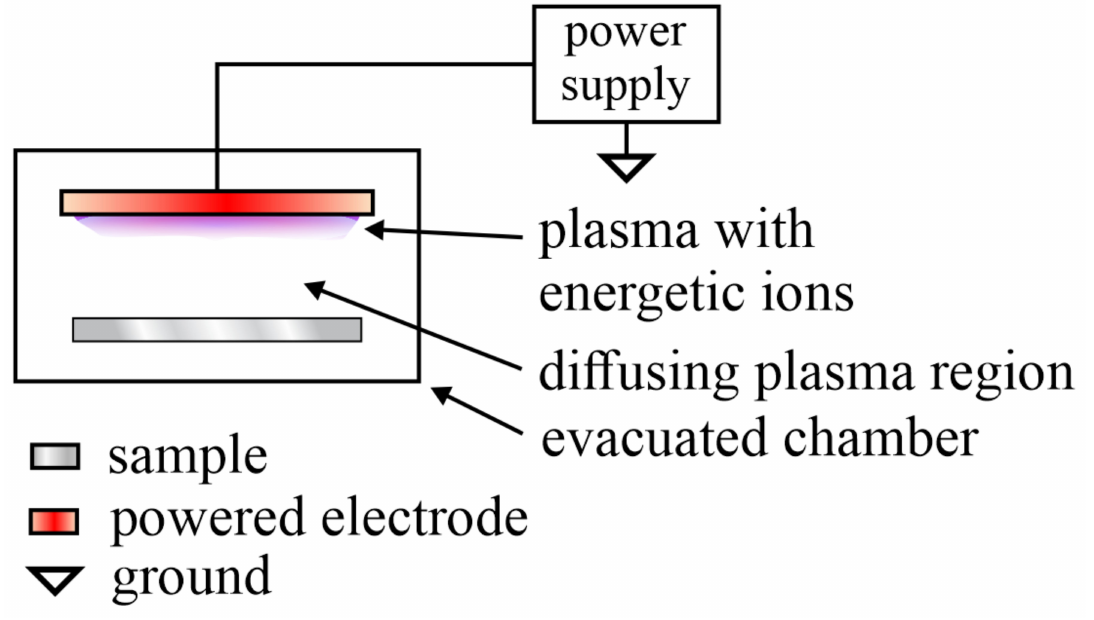
Figure 1. Schematic of the plasma reactor useful for the treatment of polyamide materials with a low-pressure gaseous